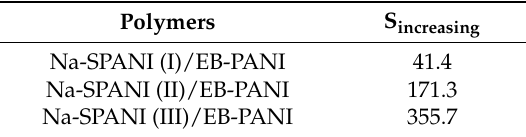
Table 3. The evaluated increasing sensitivity of three types of Na-SPANI/EB-PANI towards CO 2 .